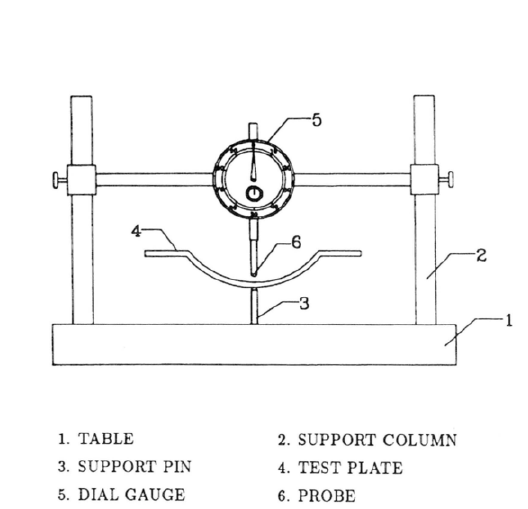
FIGURE 3 Schematic of the dial gauge set up for thickness and bulge depth measurement of exploded